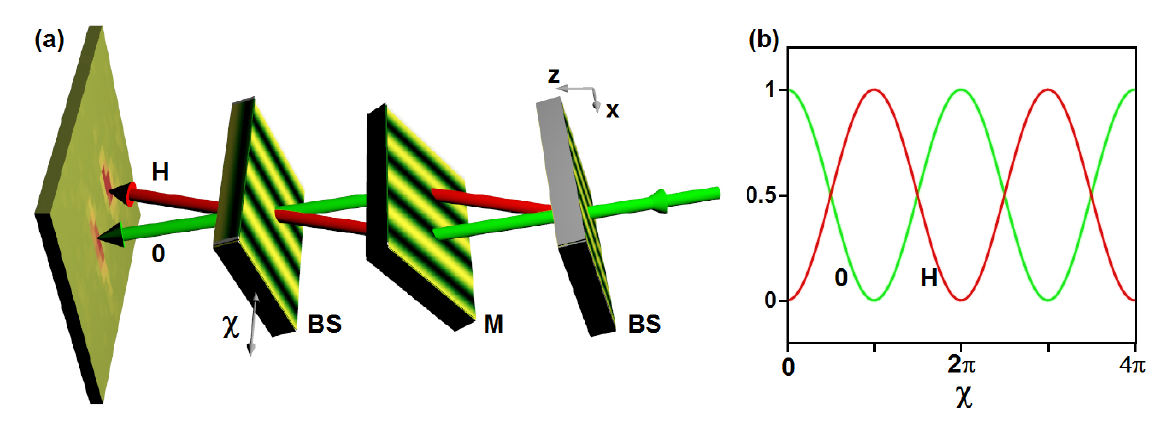
Figure 15. ( a ) Mach-Zehnder interferometer of the triple-Laue type using three NP-polymer composite gratings; ( b ) Expected (normalized) intensities of the 0- and H-beams upon stepwise shift of the third grating along the x direction for a monochromatic incident